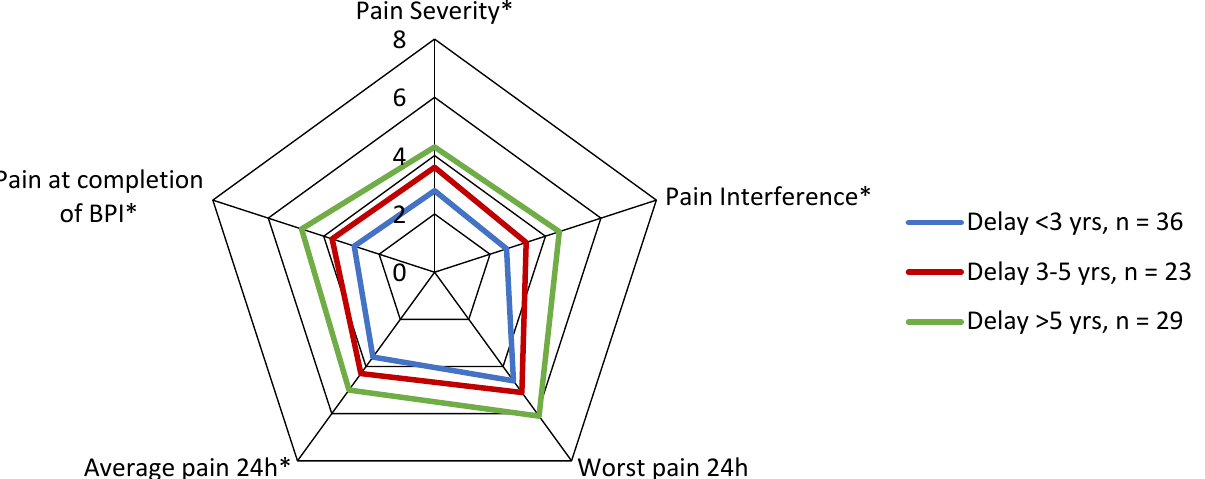
Figure 3. Radar chart comparing Brief Pain Inventory scores between CNO/SCCH patients with different lengths of delay in diagnosis <3 yrs and >5 yrs. Significance was illustrated by * p < 0.01.